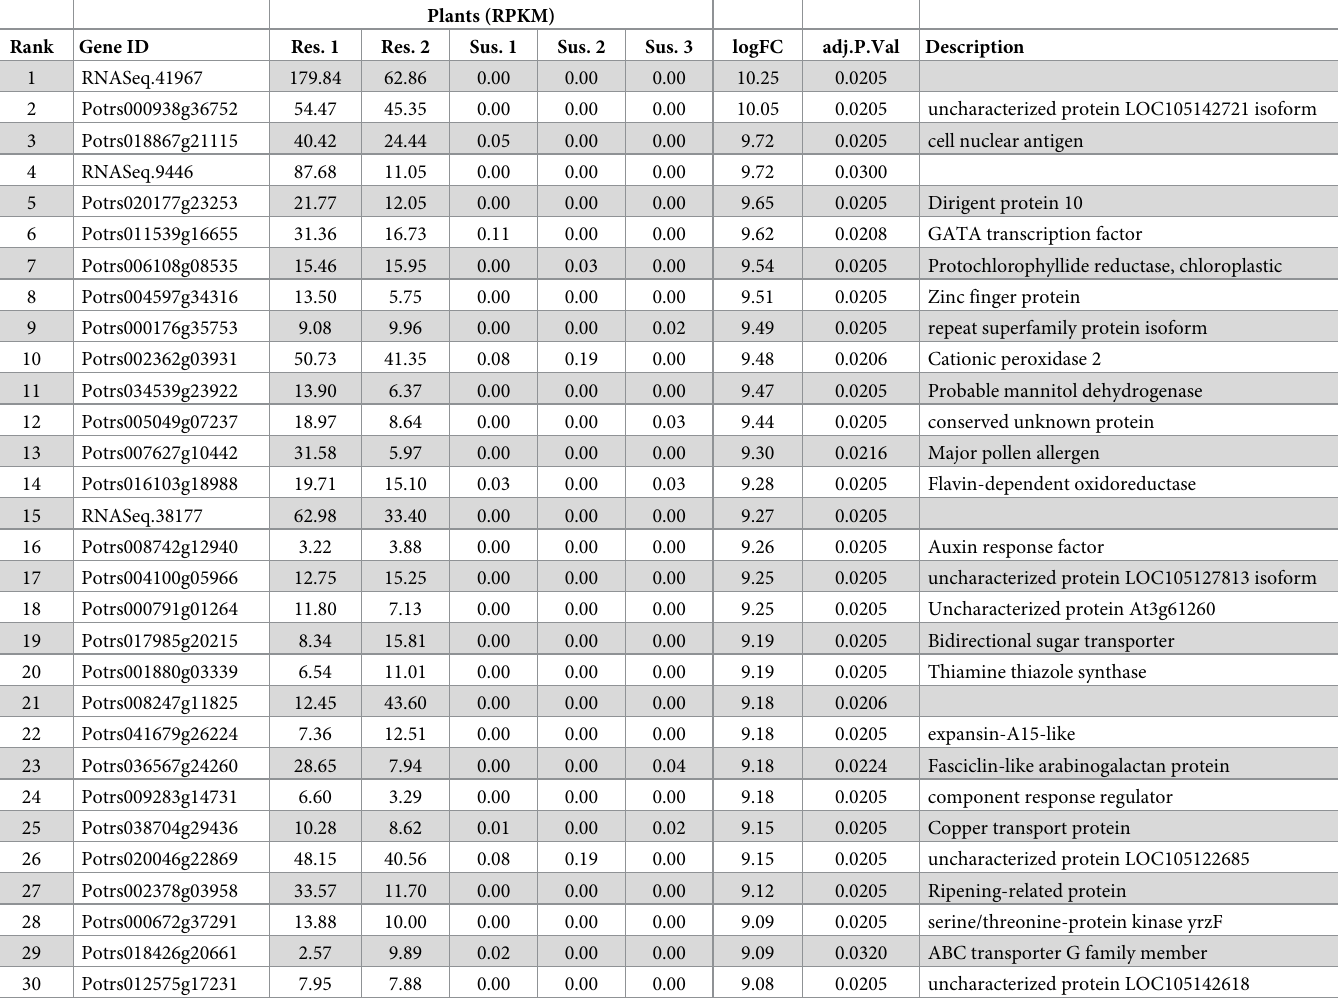
Table 2. Top 30 upregulated transcripts in resistant trembling aspen ( Populus tremuloides ) genotypes compared to susceptible trembling aspen genotypes based on